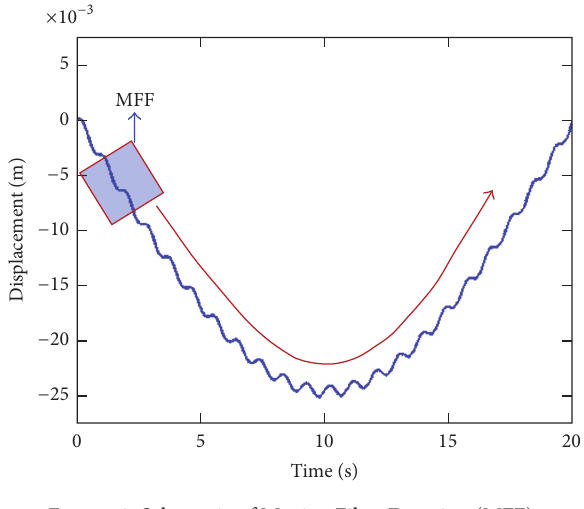
Figure 3: Schematic of Moving Filter Function (MFF).